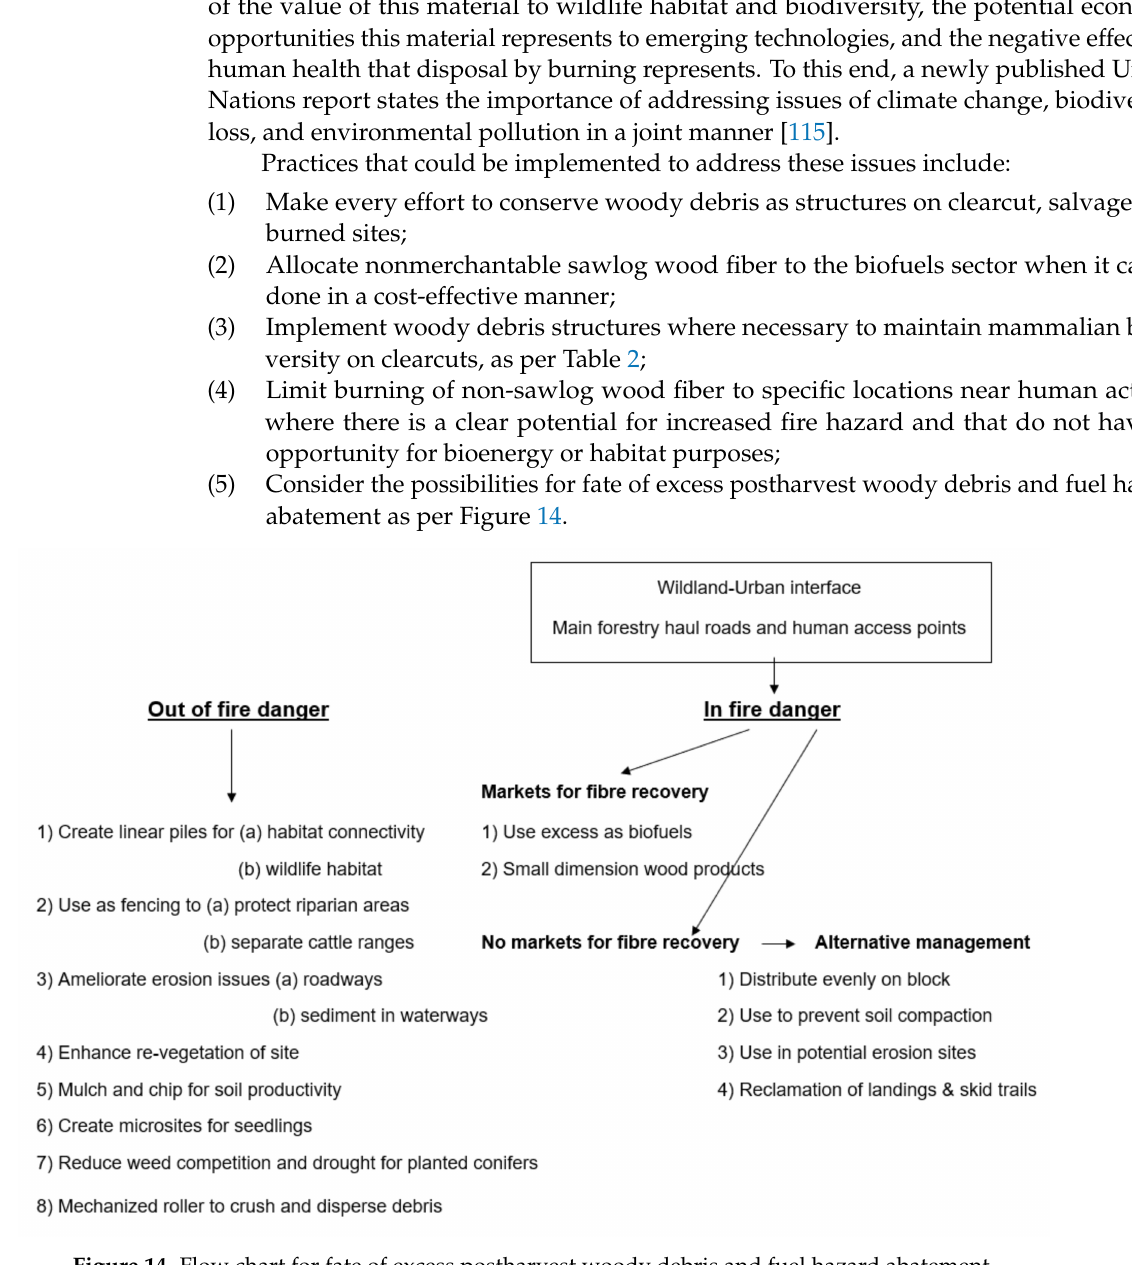
Figure 14. Flow chart for fate of excess postharvest woody debris and fuel hazard